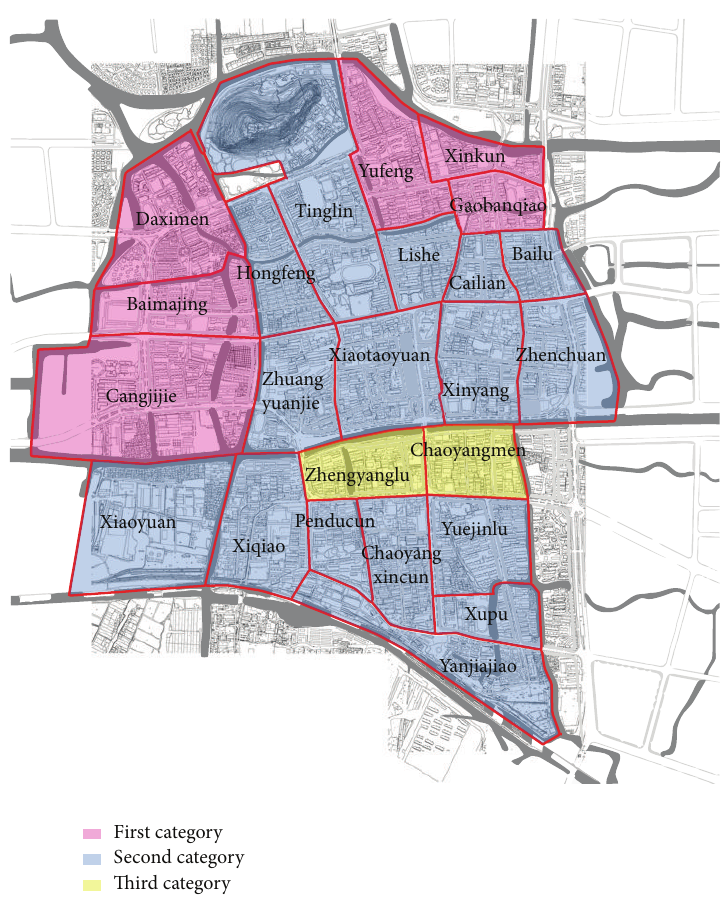
Figure 1: Community distribution map of the main urban area of Kunshan